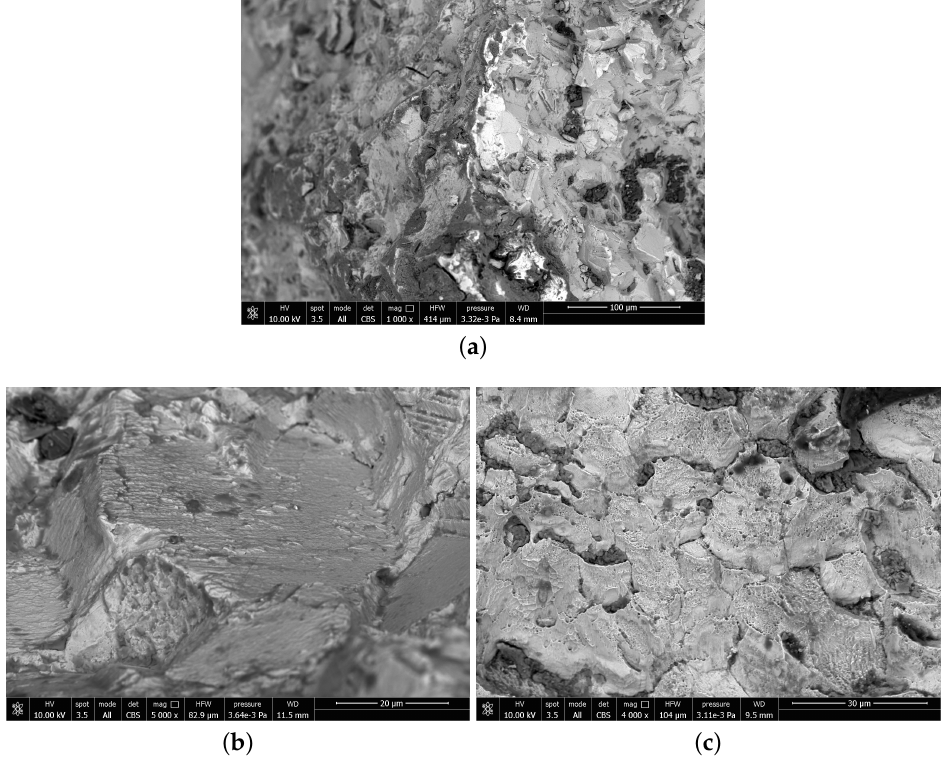
Figure 11. SEM microscopy of specimens extracted from Bar A : ( a ) border line, ( b ) opaque zone, ( c ) brilliant zone.